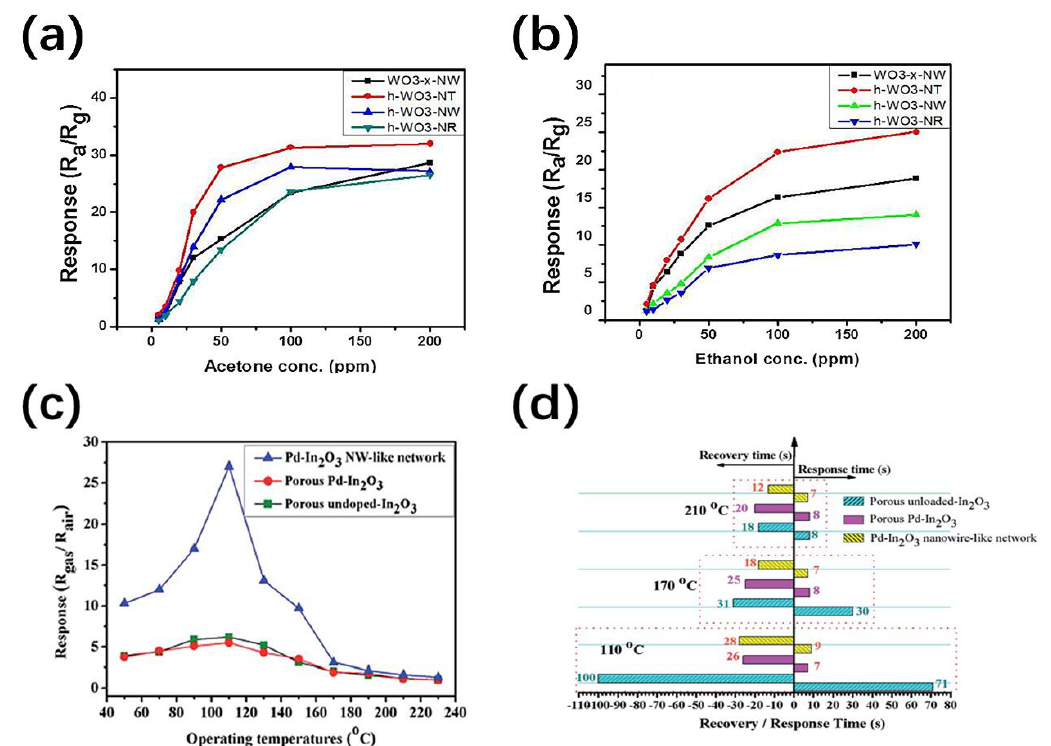
Figure 7. The response (R a /R g ) of WO 3 − x nanowire, h-WO 3 nanotube, h-WO 3 nanowire and h-WO 3 nanorod versus acetone ( a ) and ethanol ( b ) concentration [77]; ( c ) the response of porous unloaded-In 2 O 3 , porous Pd–In 2 O 3 and Pd–In 2 O 3 NW-like network under different temperatures to 5 ppm NO 2 [90]; ( d ) the response and recovery times of three samples to 5 ppm NO 2 at 110, 170 and 210 °C [90].